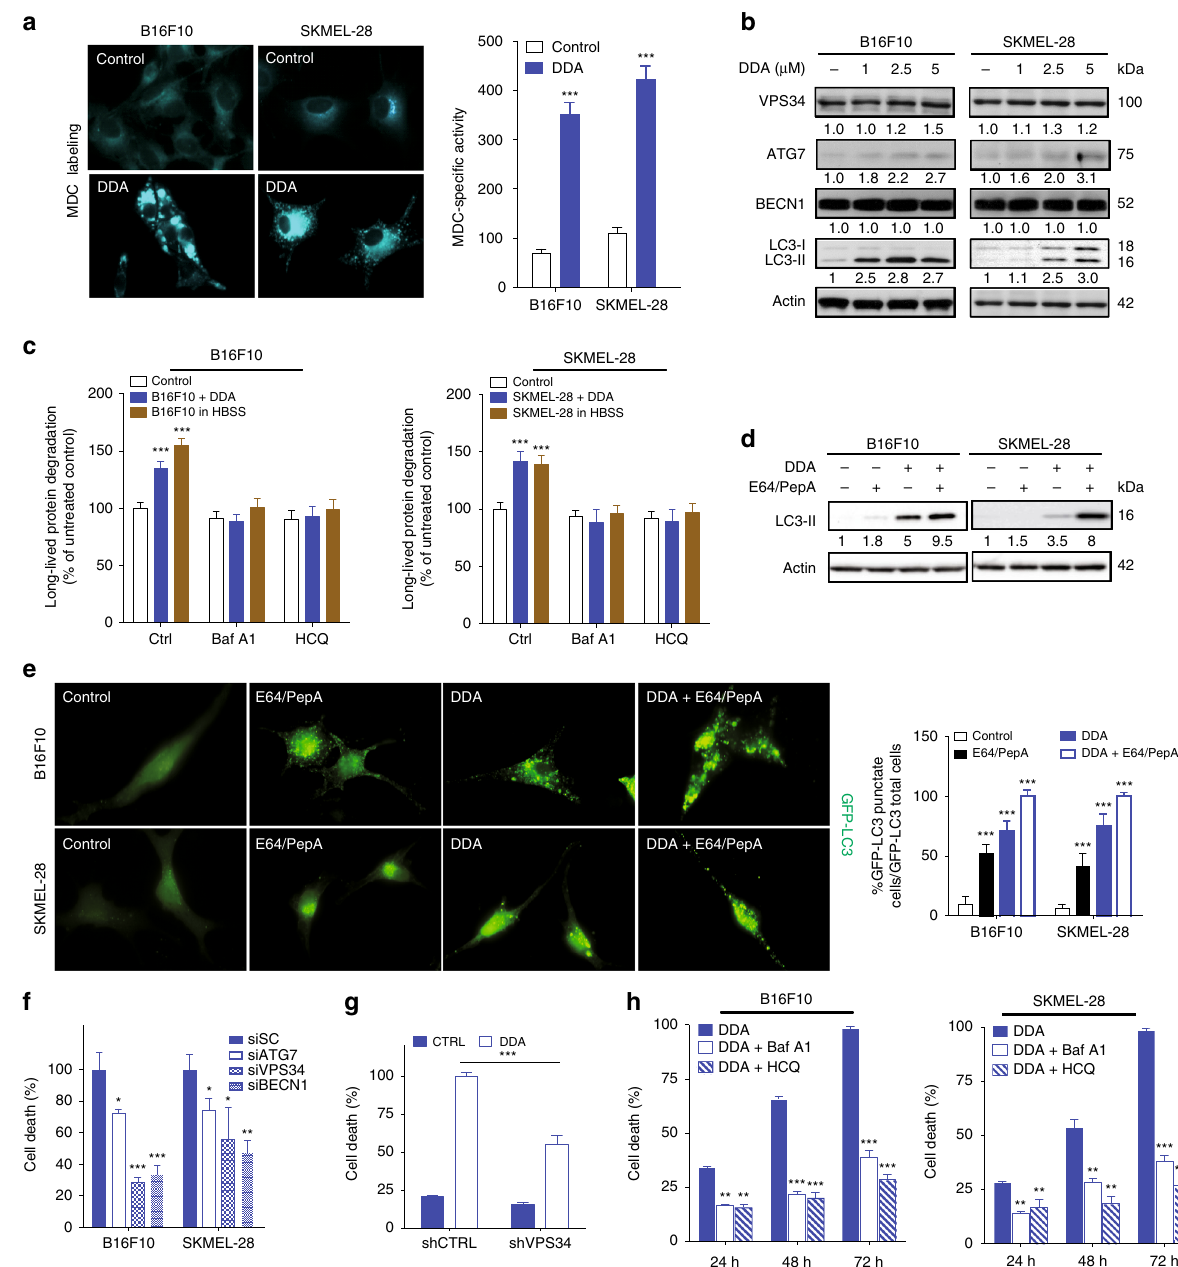
Fig. 2 DDA induces Nur77- and NOR1-dependent lethal autophagy in melanoma cells. a DDA triggers the accumulation of autophagic vesicles. Cells were treated for 24 h with or without 2.5 µ M DDA then stained with monodansylcadaverine (MDC) and observed by fl uorescence microscopy. MDC-speci fi c activity was measured by fl uorescence photometry. b Cells were treated for 24 h with solvent vehicle or increasing concentrations of DDA then analyzed for autophagic protein expression by immunoblotting. Blots are representative of three independent experiments. c Long-life protein degradation was determined in cells treated with solvent vehicle (control) or 1 µ M DDA for 18 h in the presence or absence of the autolysosomal inhibitors ba fi lomycin A1 (Baf A1) and hydroxychloroquine (HCQ). Autophagic activity was measured as the level of degradation of long-lived proteins. Starvation for 18 h in Hank ’ s balanced salt solution (HBSS) was used as a positive control. d Immunoblots of LC3 proteins from cells treated for 24 h with or without 2.5 µ M DDA and with or without E64 + pepstatin A (10 µ g/ml). Images are representative of three independent experiments. e DDA induced the formation of punctate LC3 cells. Cells were transfected with a plasmid-expressing GFP-LC3 and then treated for 24 h with the solvent vehicle or 2.5 µ M DDA, with or without E64 + pepstatin A (10 µ g/ml) and observed by fl uorescent microscopy. The percentage of GFP-LC3-positive cells with GFP-LC3 puncta was calculated. f Analysis of DDA cytotoxicity in cells transfected with scramble siRNA (siSC), siATG7, siVPS34, or siBECN1. Seventy-two hours after transfection, cells were treated or not for 24 h with 2.5 µ M DDA. g Analysis of DDA cytotoxicity in SKMEL-28 cells permanently transfected with control shRNA (shCTRL) or shRNA against VPS34 (shVPS34). Cells were treated for 72 h with solvent vehicle (CTRL) or 2.5 µ M DDA. h Cells were treated with 2.5 µ M DDA for 24, 48 and 72 h in the presence or absence of the autolysosome inhibitors Baf A1 or HCQ. Cell death is expressed as in Fig. 1a. Data from a , c , e , f , g are the means ± S. E.M. of three experiments performed in triplicate, * P < 0.05, ** P < 0.01, *** P < 0.001, t